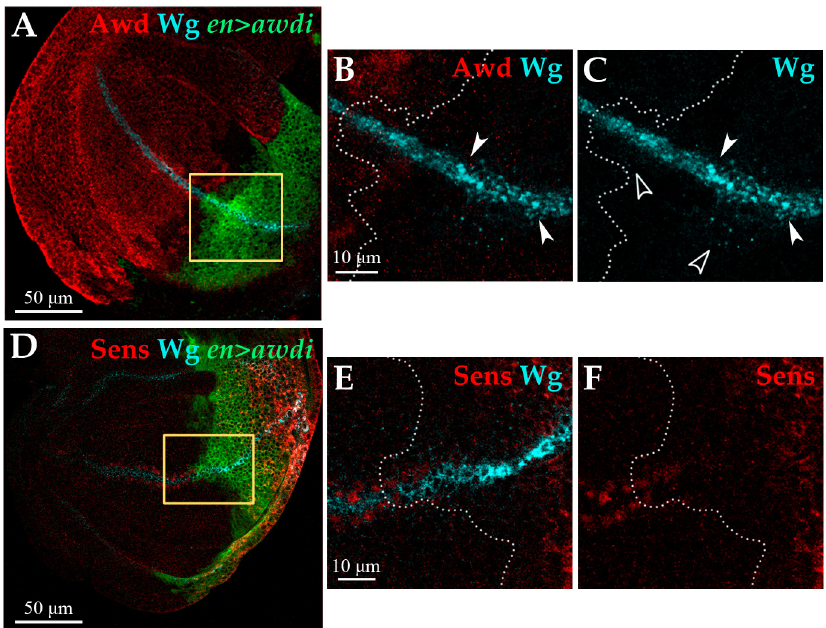
Figure 5. awdi impairs Wg signaling. Confocal microscopy images of wing discs dissected from en > awdi larvae. Wing discs are labelled by anti-Awd ( A , B ), anti-Wg ( A – E ), anti-Sens ( D , F ). Yellow boxes in ( A , D ) outline the enlarged area showed in ( B , C , E , F ) respectively. White dots outline the boundary between anterior and posterior compartments ( B , C , E , F ). White arrowheads mark large aggregates of Wg protein, empty arrowheads mark Wg spots ( B , C ).